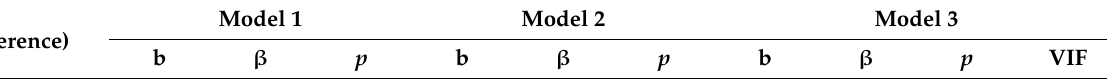
Table 4. Effects of COVID-19 Health Belief, Knowledge, and Attitude on Prevention Behavior ( n =